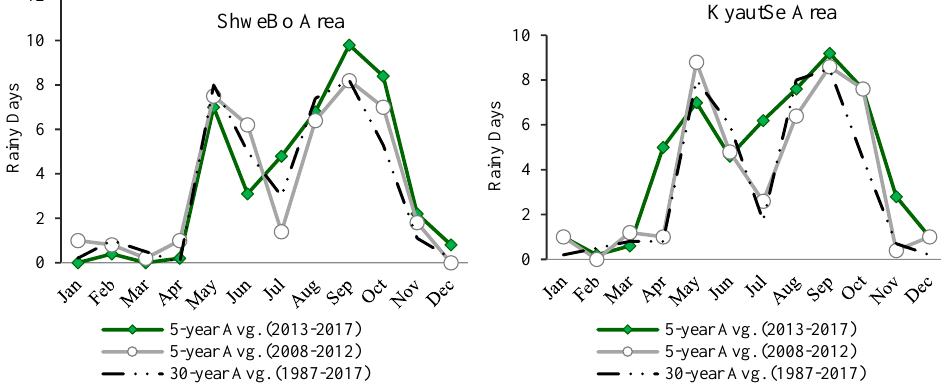
Figure 3. Distribution and pattern of average monthly rainy days in ShweBo and KyautSe.